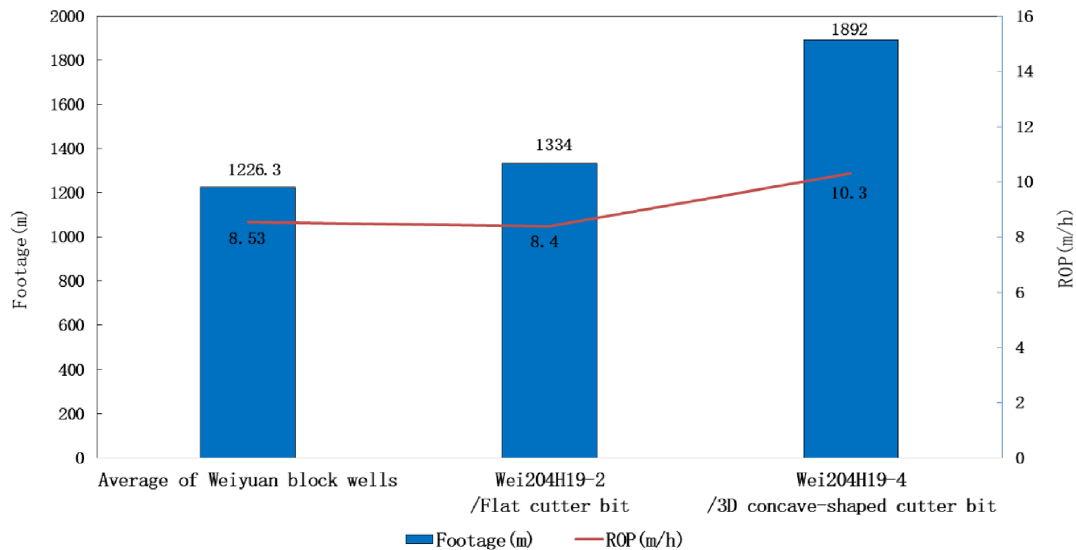
Fig. 25 Comparison between the performance of the PDC bit with a flat cutter and a 3D-shaped